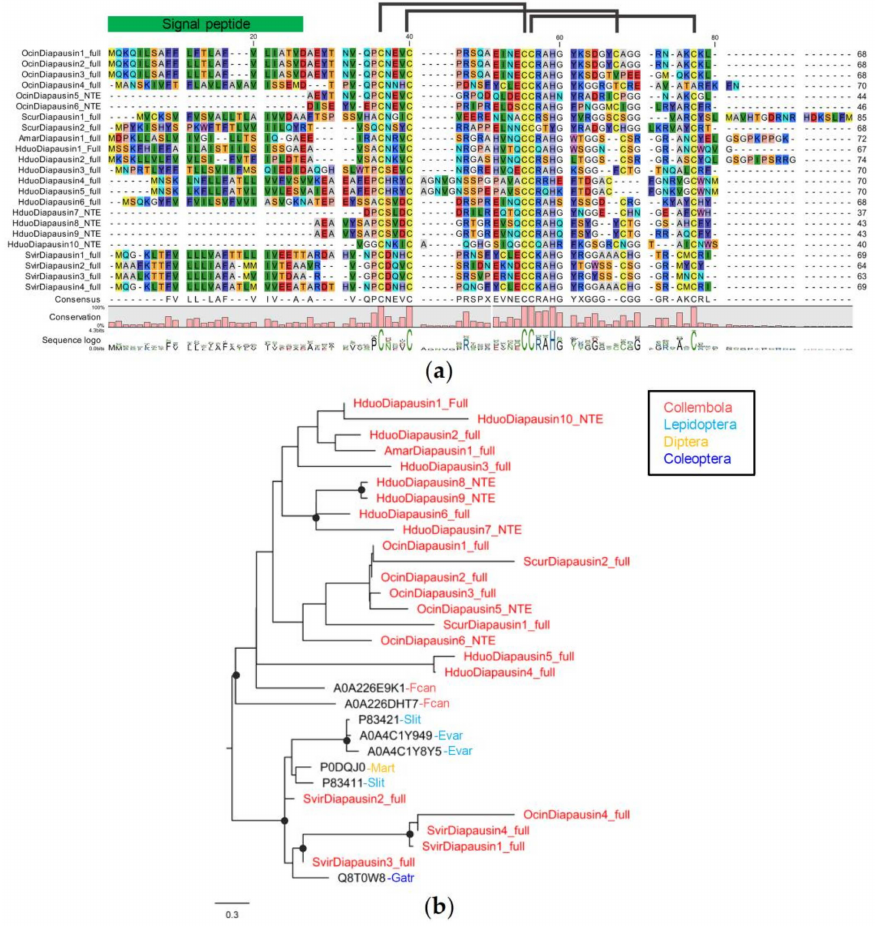
Figure 3. Sequence alignment and phylogenetic relationships of collembola diapausin: ( a ) protein alignment showing disulfide bridges between six conserved cysteine residues; ( b ) Phylogenetic tree of arthropod diapausins. Branch supports (aLRT) higher than 0.9 were indicated with black dots on tree nodes (Abbreviation: Fcan = F. candida , Hduo = H. duospinosa , Amar = A. maritima , Ocin = O. cincta , Scur = Si. curviseta , Svir = Sm. viridis , Slit = Spodoptera littoralis , Evar =